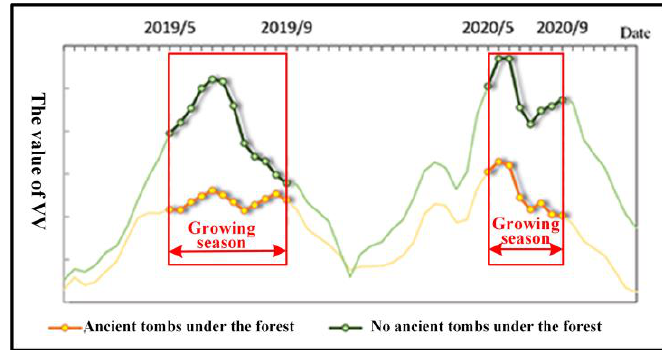
Figure 12. Timing-series features of VV.